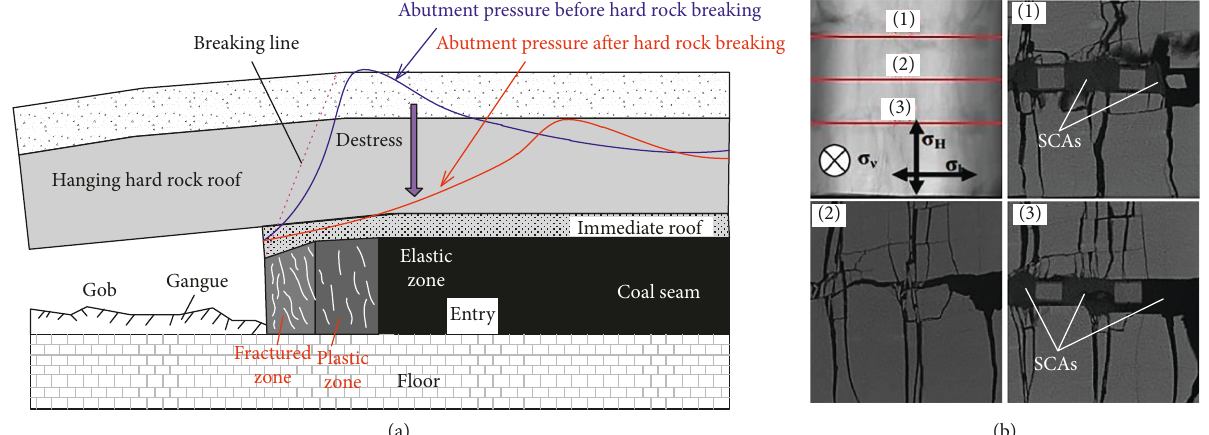
Figure 1: (a) Schematic of SCA application in hard rock breaking in coal mine. (b) CTscanning images of SCA-induced fractures in shale